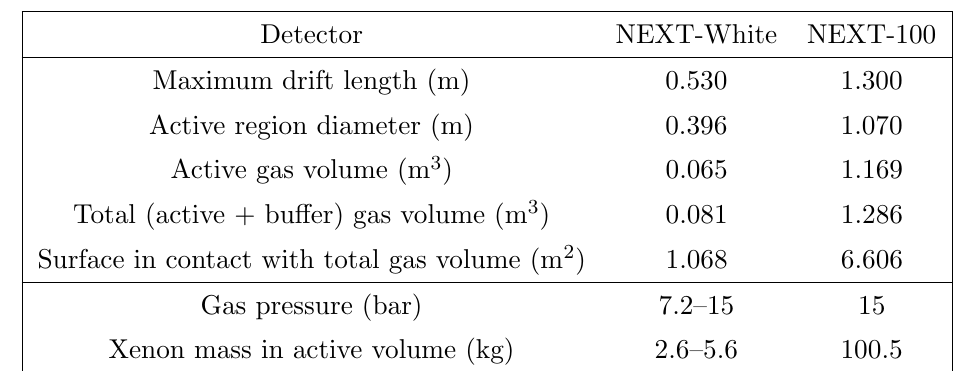
Table 4 . Comparison of NEXT-White and NEXT-100 detector geoemtries, and adopted/planned run